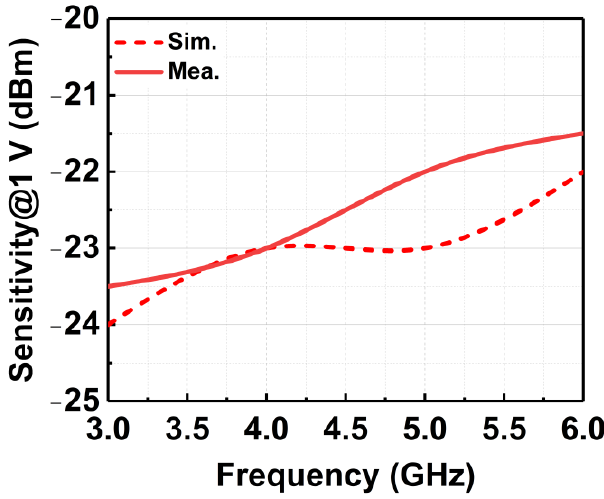
Figure 21. Sensitivity of the CCDD-TVB rectifier across wideband frequency.